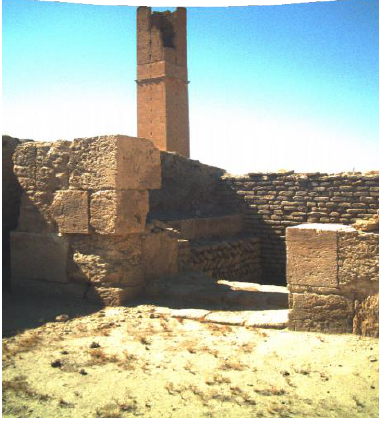
Figure 3. Study area